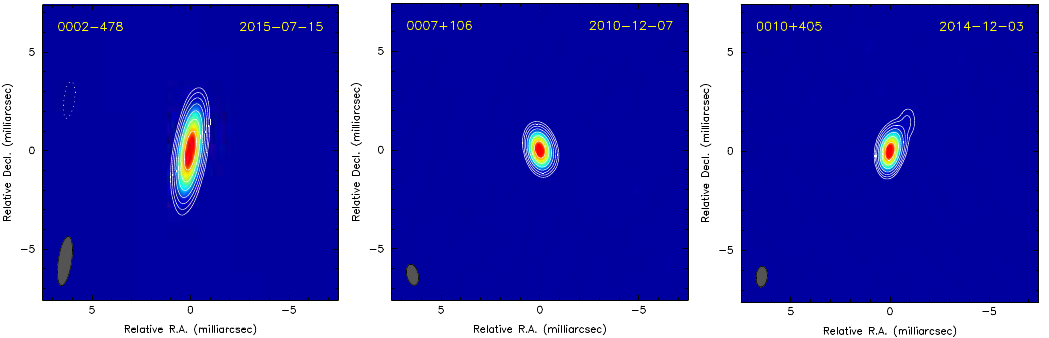
Figure 4. Very Long Baseline Interferometry (VLBI) maps at X-band for three ICRF-3 defining sources (0002–478, 0007+106, and 0010+405). Contour levels are drawn at ± 1, 2, 4, 8, 16, 32, and 64% of the peak brightness. These maps are from the Bordeaux VLBI Image Database, BVID [25]. See https: //bvid.astrophy.u-bordeaux.fr/ (accessed on 13 May 2022) for full details on the map parameters.